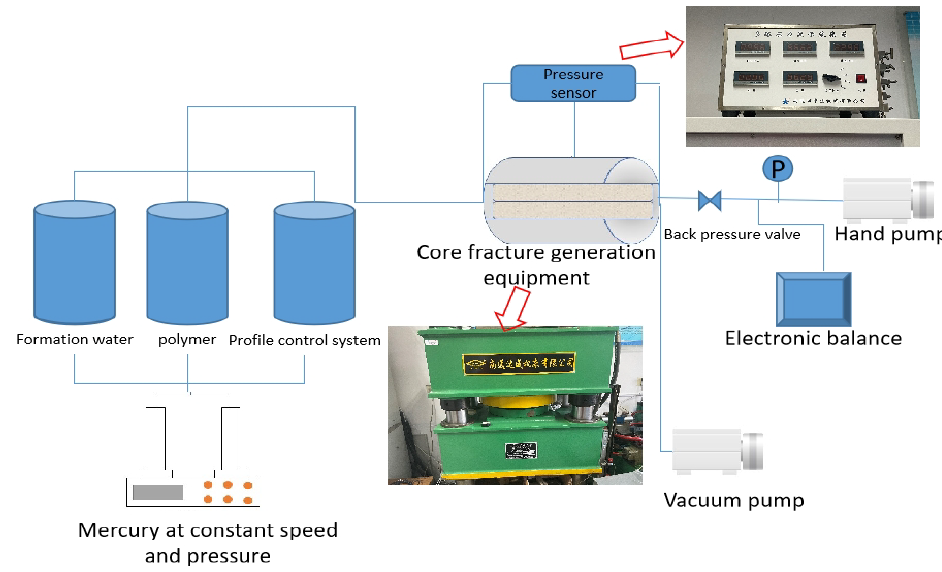
Figure 5. Experimental flow chart.